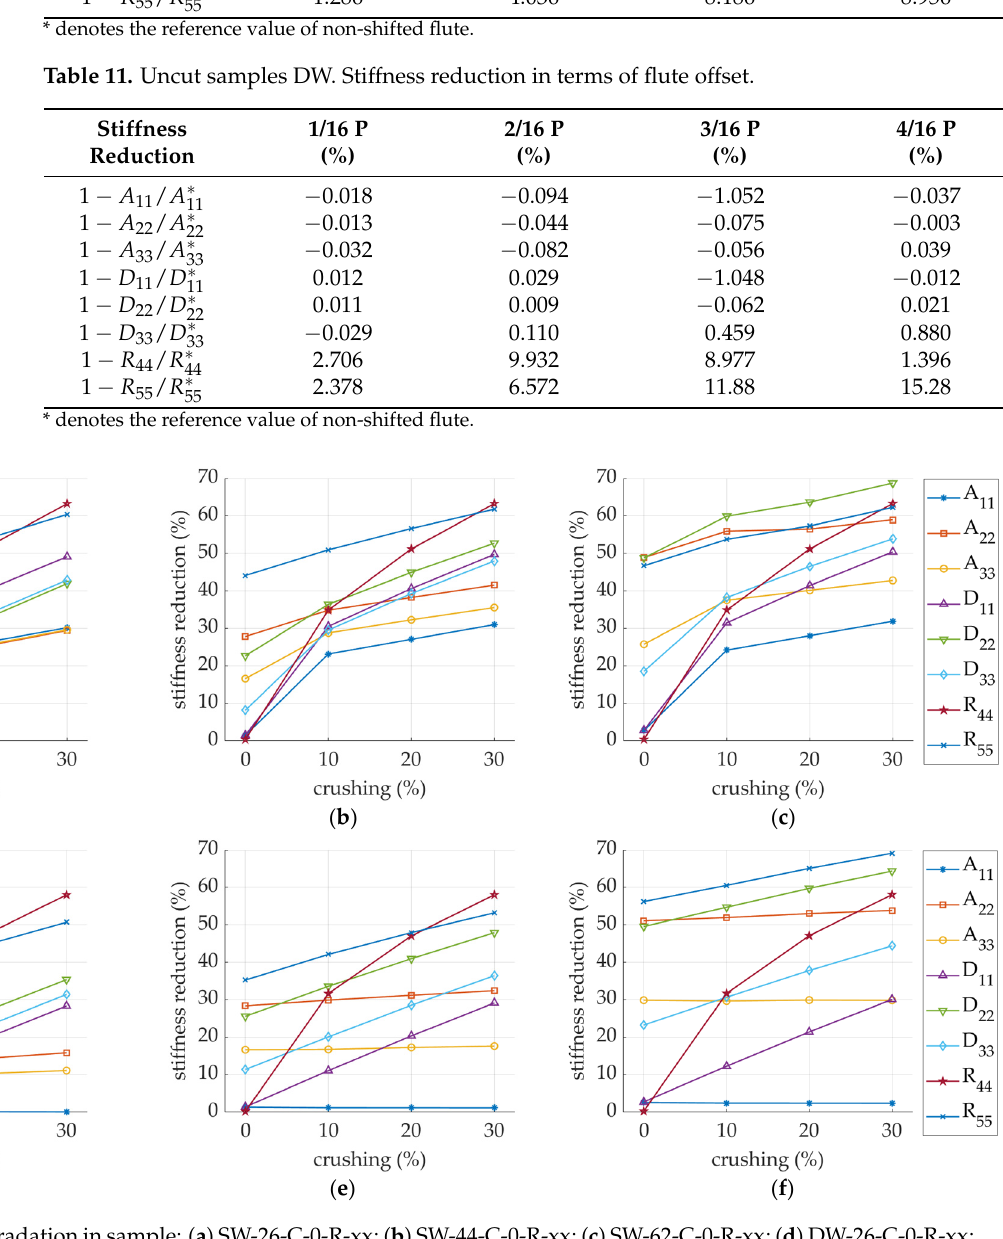
Figure 16. Stiffness degradation in sample: ( a ) SW-26-C-0-R-xx; ( b ) SW-44-C-0-R-xx; ( c ) SW-62-C-0-R-xx; ( d ) DW-26-C-0-R-xx; ( e ) DW-44-C-0-R-xx; ( f ) DW-62-C-0-R-xx. Here xx is a crush level (0%; 10%, 20%, and 30%).